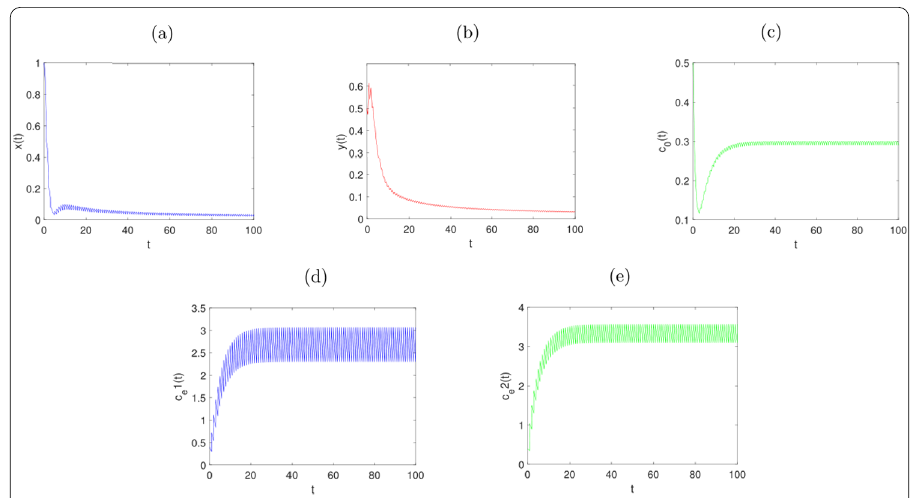
Figure 1 The permanence of system (2.1) with x ( t ) = 1, y ( t ) = 0.5, c o ( t ) = 0.5, c e 1 ( t ) = 0.4, c 1 = 0.1, d 1 = 0.1, β 1 = 0.01, d 2 = 0.3, β 2 = 0.01, f = 0.1, g = 0.4, m = 0.5, h 1 = 0.3, h 2 = 0.15, a = 0.4, b = 1, c 2 = 0.5, d 3 = 0.1, E 1 = 0.08, d 4 = 0.1, E 2 = 0.05, u 1 = 0.01, u 2 = 0.03, d = 0.5, v 1 = 0.4, v 2 = 0.5, l = 0.5, τ = 1; ( a ) time series of x ( t ); ( b ) time series of y ( t ); ( c ) time series of c o ( t ); ( d ) time series of c e 1 ( t ); ( e ) time series of c e 2 ( t )